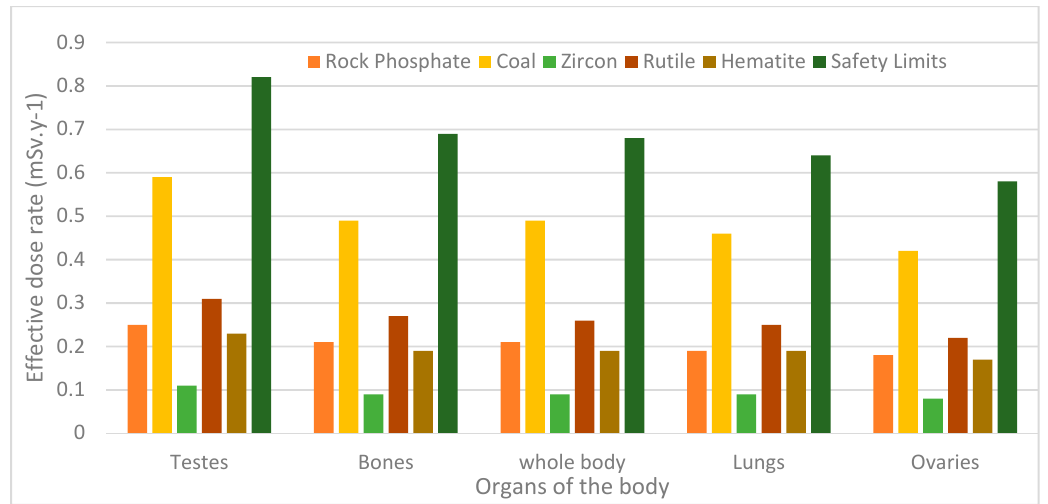
Figure 4. Annual effective dose rate delivered to selected organs of the body.